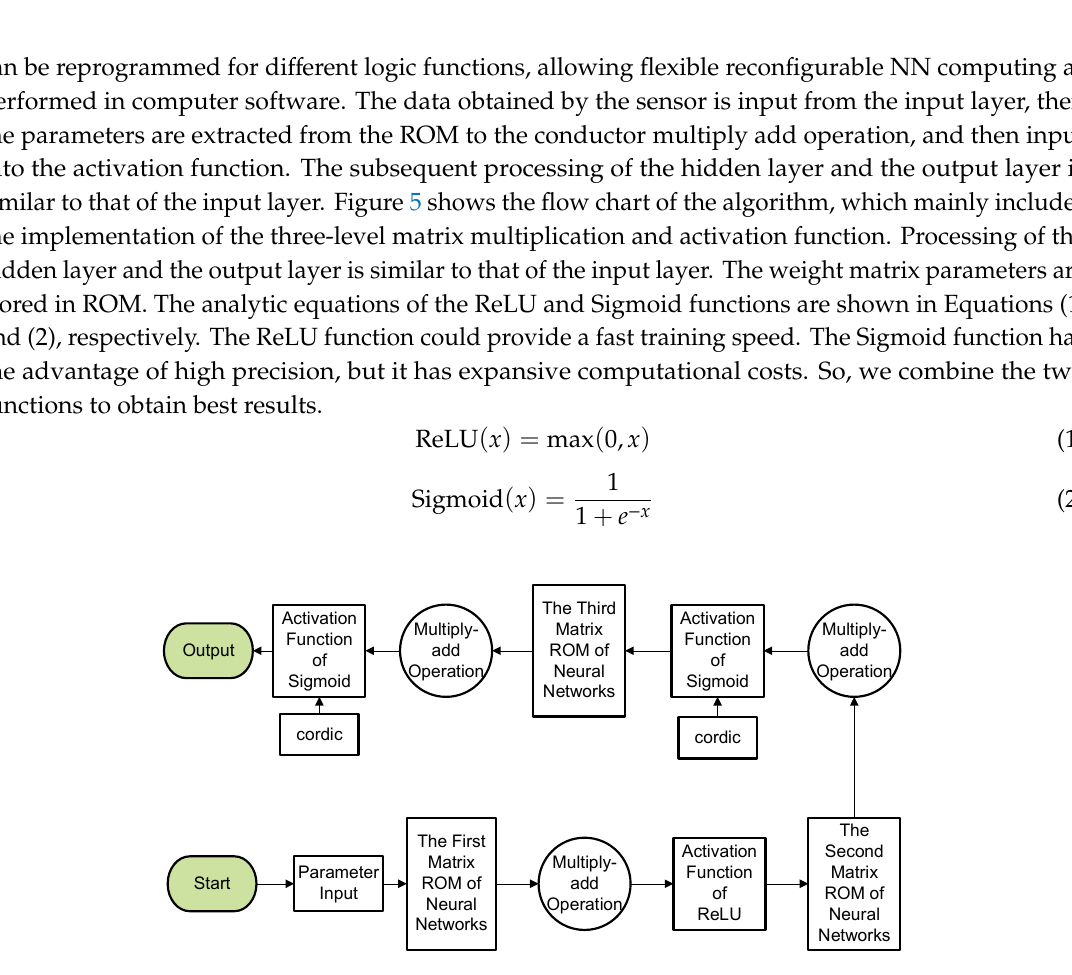
Figure 5. Flow chart of FPGA-based MLP NN implementation.